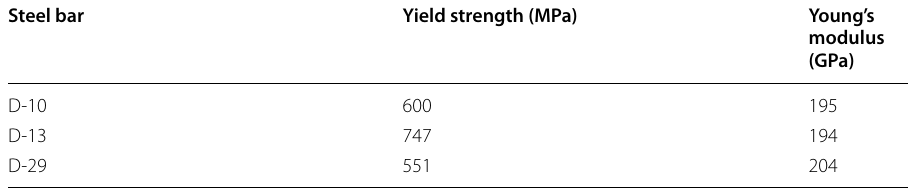
Table 1 Mechanical properties of steel at ambient temperatures Steel